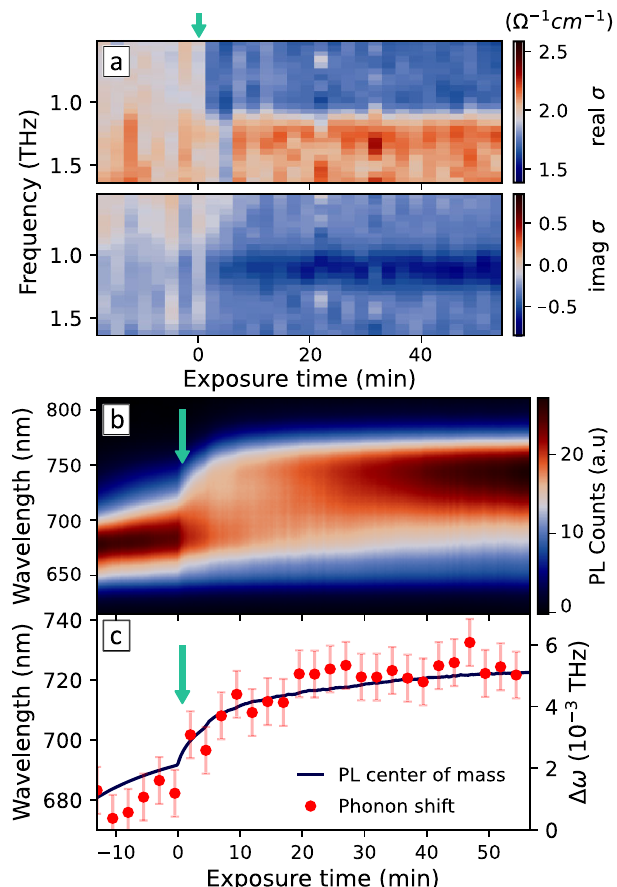
Fig. 2 Simultaneous observation of halide segregation and enhanced phonon anharmonicity. a Evolution of the THz photoconductivity spectra taken at 10 ps delay after 400nm photoexcitation. The green arrow indicates when exposure to the 532 nm CW laser starts (at t inducing phase segregation. The intensity of the CW laser was slowly ramped from 0 to 500 mW/cm 2 over the experiment to obtain a gradual segregation process. b PL spectral evolution of the MAPb(I 0.5 Br 0.5 ) 3 thin fi lm during segregation. c PL centroid (i.e., weighted mean, blue) and photoexcitation-induced phonon frequency shift Δ ω (red dots) extracted from fi ts to the THz photoconductivity spectra (at t pump = 10 ps) during phase segregation. Error bars represent the average standard deviation of the fi